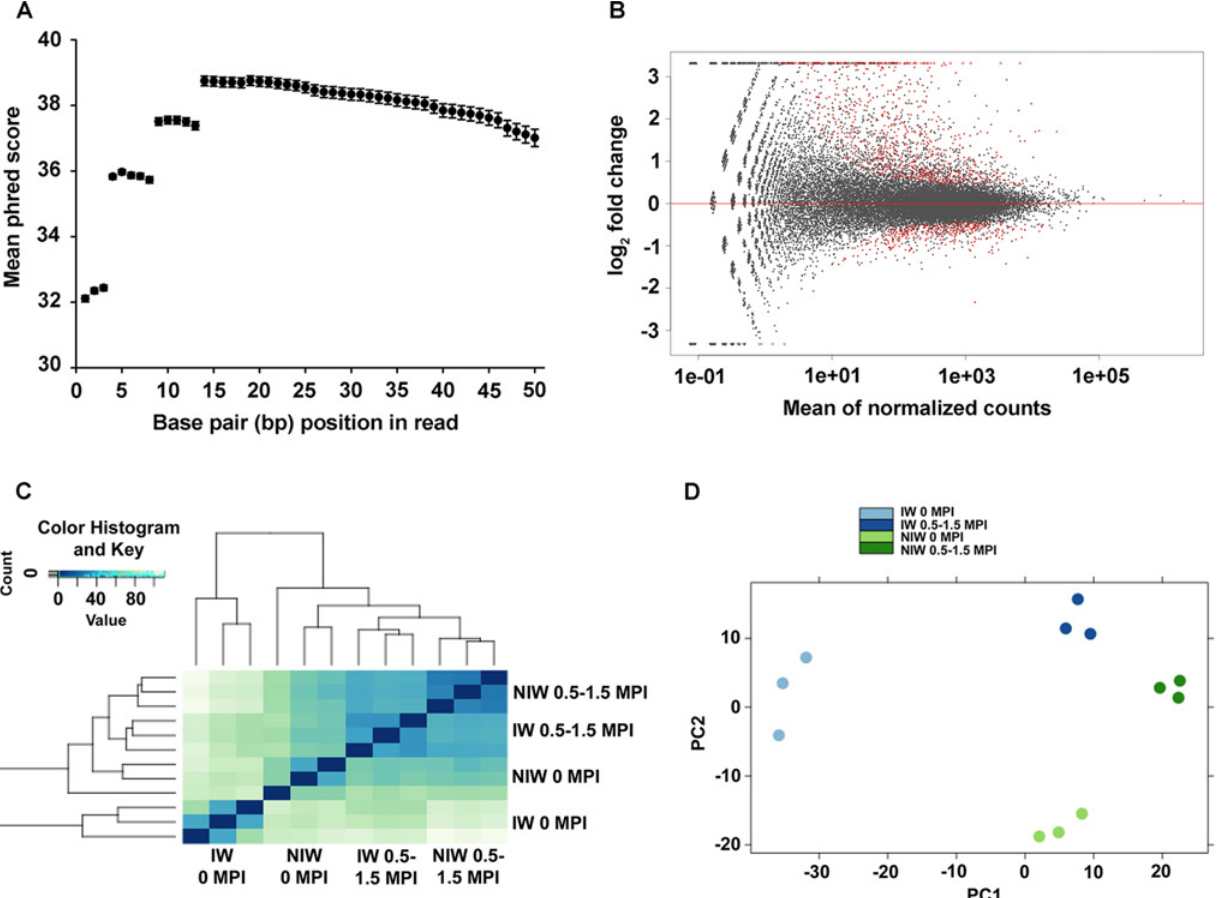
Fig 4. RNA-Seq revealed transcriptional differences in leaves of the four treatment-time combinations. (A) Per-base quality score plot shows the average Phred+33 score of all 12 samples. Error bars represent standard deviations. (B) Scatter plot showing differential expression for the contrast IW vs. NIW at 10% FDR. Red-coloured dots represent DEGs. Those positioned farthest from the x-axis, at the upper and lower plot borders, have very large to infinite log 2 -fold changes. (C) Heatmap showing Euclidean distances among the 12 libraries, calculated from Variance stabilized transformed (VST) count data. Colour key indicates level of similarity between libraries. (D) Principal Component Analysis (PCA) of the first two principal components (PC1, PC2).